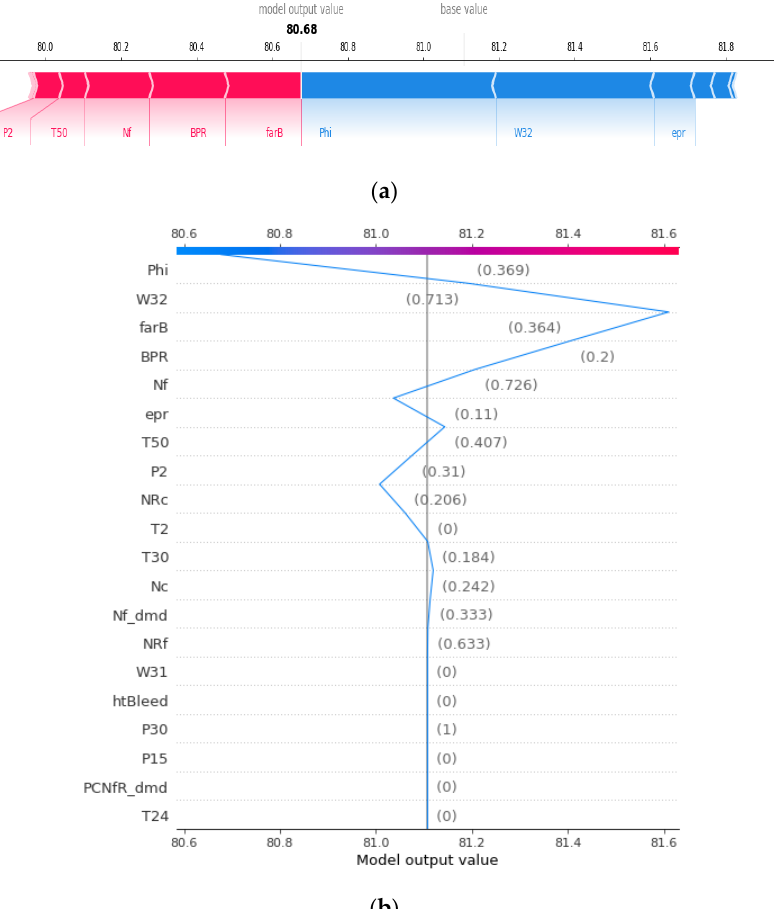
Figure 7. ( a ) SHAP force plot for engine No. 41 and ( b ) SHAP decision plot for engine No. 41.